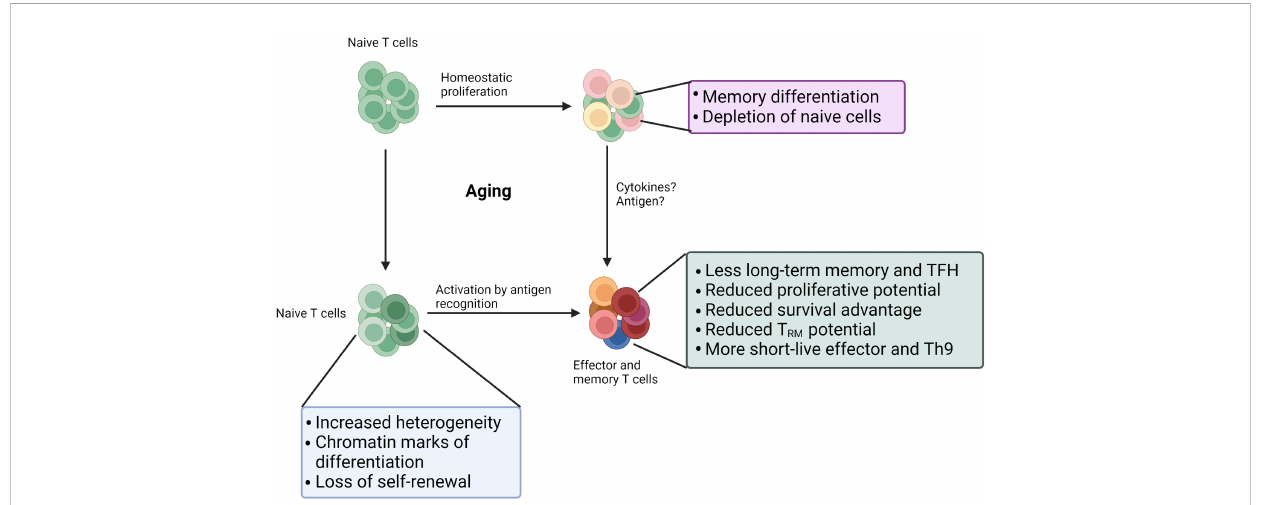
FIGURE 1 Age-related changes in the T cell. Self-renewal of naïve T cell cells via homeostatic proliferation often fails in old individuals: 1) memory differentiation driven by homeostatic cytokines; 2) death due to lack of survival signal. Age also leads to signi fi cant changes in naïve T cell compartment: more differentiated states, increased heterogeneity, and reduced quiescence. Those changes in naïve T cells combined with changes in activation stages result in dysfunctions in aged effector or memory T cells. Furthermore, age impairs the function of existing